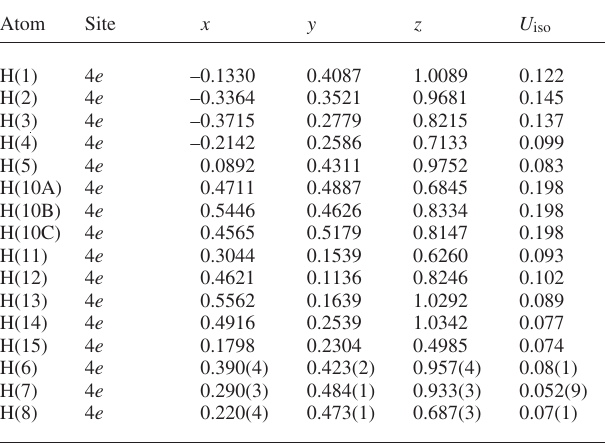
Table 2. Atomic coordinates and displacement parameters (in Å 2 )